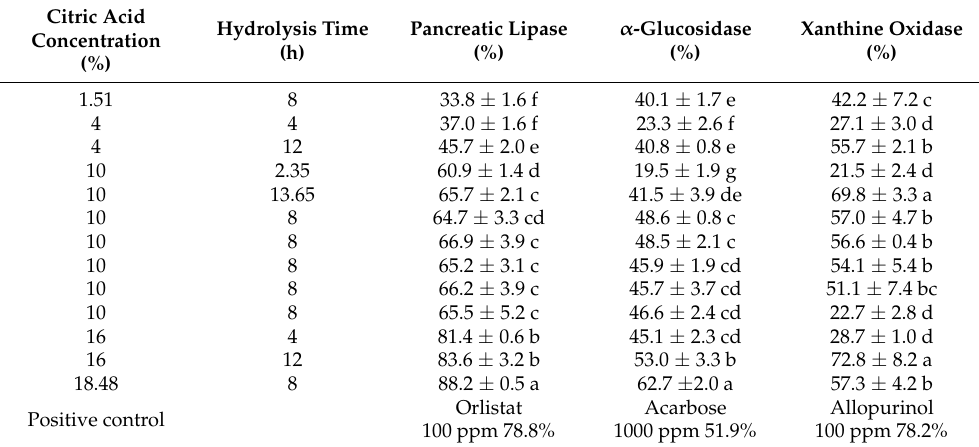
Data are expressed as the mean ± standard deviation of triplicate experiments. The mean values with different letters (a–g) in each column are significantly different ( p < 0.05 by Duncan